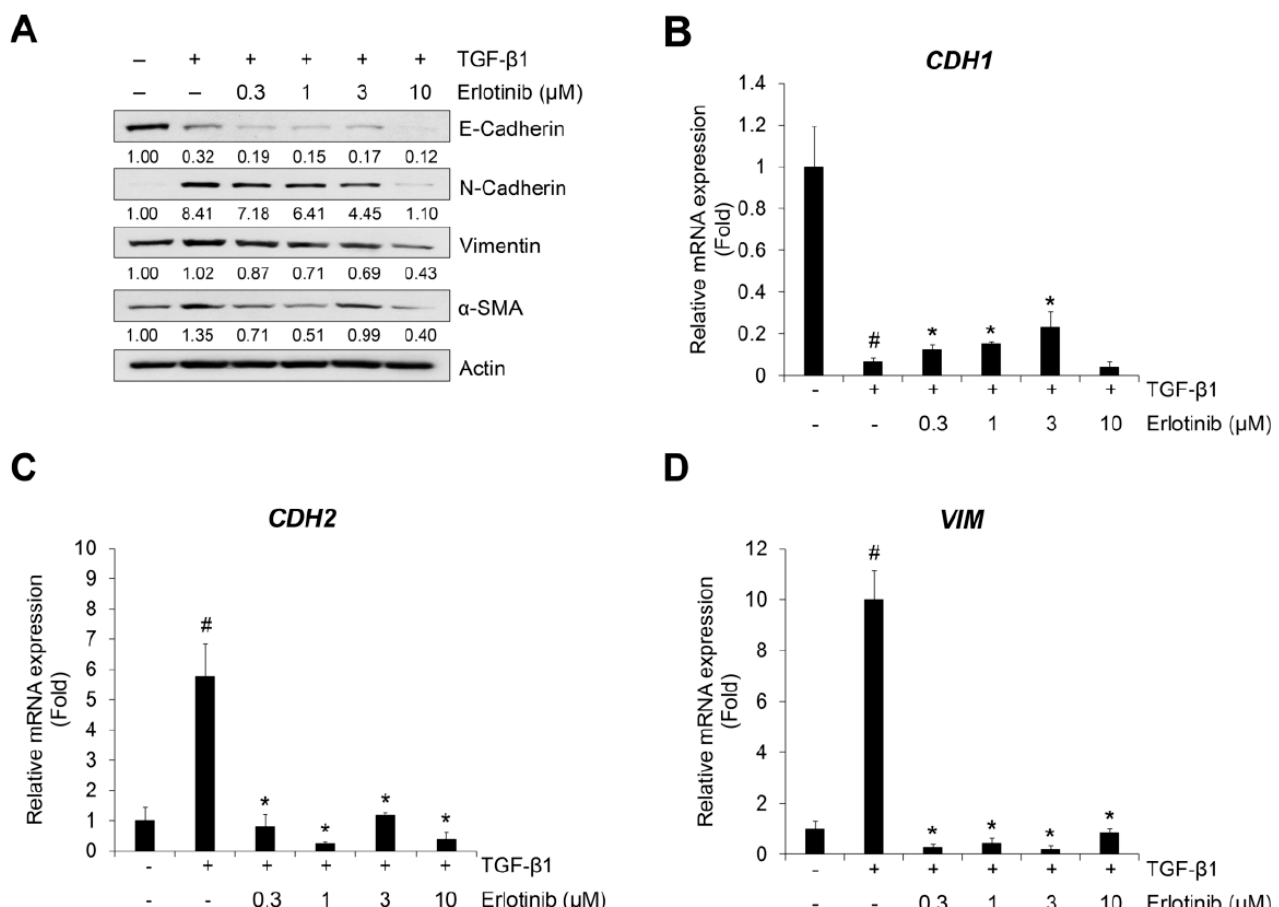
Figure 2. Erlotinib inhibits TGF- β 1–induced expression of EMT markers. ( A ) Serum-deprived A549 cells were treated with TGF- β 1 (5 ng/mL) or in combination with erlotinib for 72 h. Protein expression of an epithelial marker (E-cadherin) and mesenchymal markers (N-cadherin, vimentin, and α -smooth muscle actin) was determined by Western blot analysis. Actin was used as a loading control. ( B – D ) Serum-deprived A549 cells were incubated with TGF- β 1 (5 ng/mL) and erlotinib for 48 h. After RNA extraction and cDNA synthesis, we performed qRT-PCR to measure the expression of CDH1 , CDH2 , and VIM mRNA using GAPDH as an internal control. # p < 0.01 versus control; * p < 0.05 versus the group treated with TGF- β 1